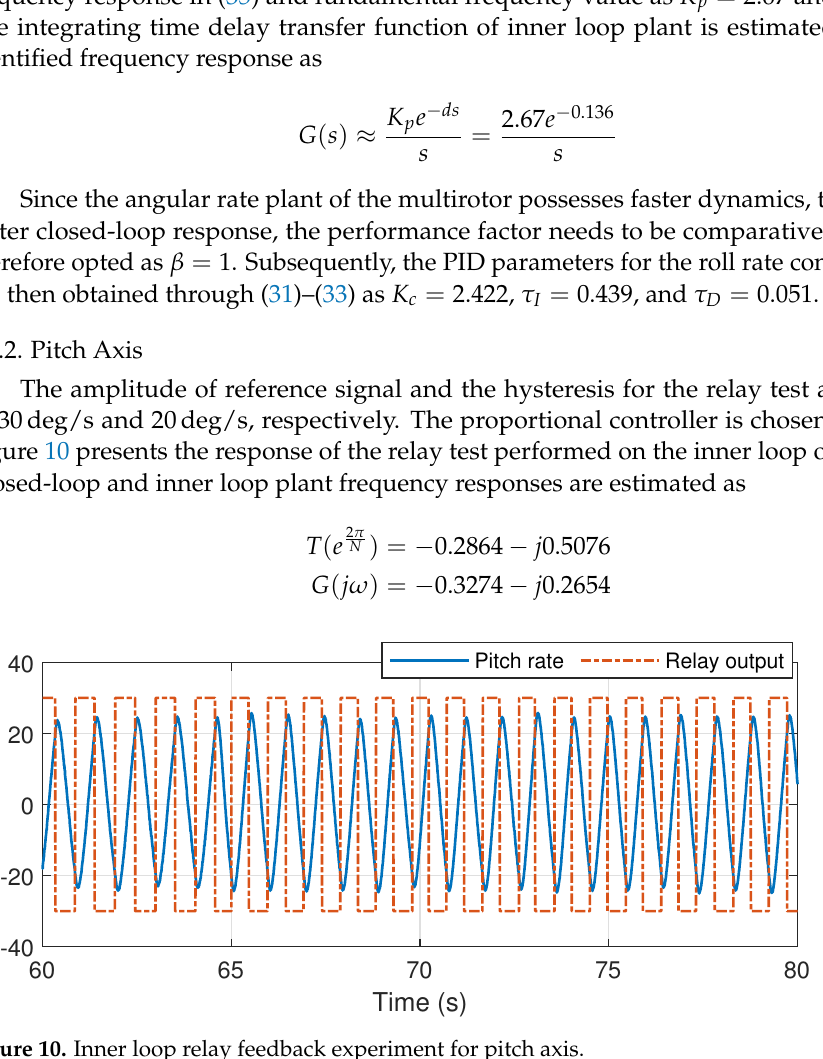
Figure 10. Inner loop relay feedback experiment for pitch